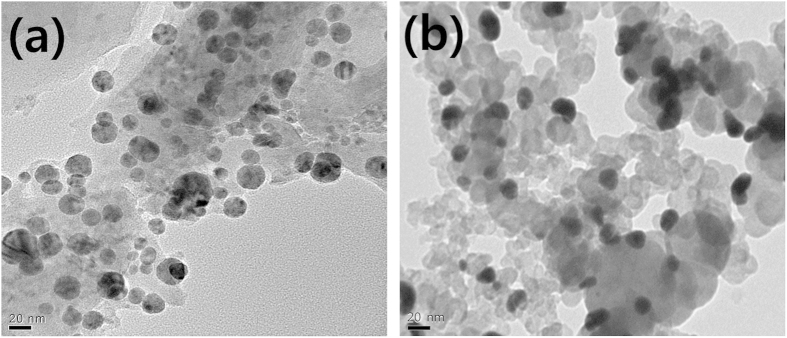
TEM micrographs of (a) Ag/LaMnO3 and (b) Ag/C.